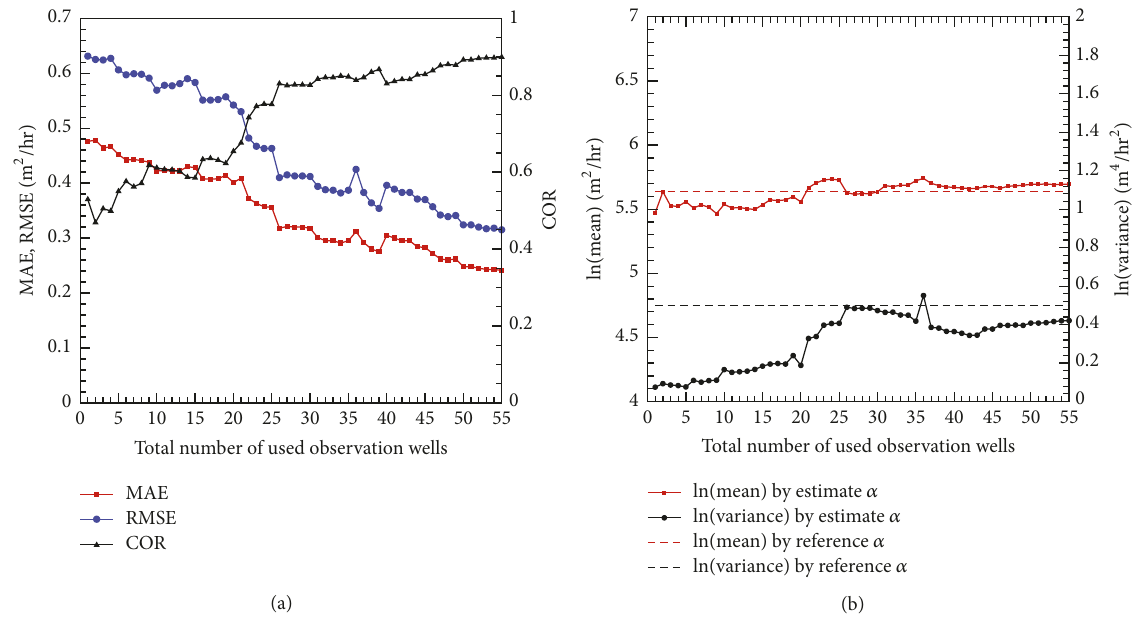
Figure 8: Total number of used observation wells for investigating the estimated heterogeneous 𝛼 field results in the synthetic aquifer. (a) Errorandcorrelationgraphoftheestimated 𝛼 versusthereference 𝛼 ;(b)theln (mean)andln (variance)graphoftheestimated 𝛼 andreference 𝛼 .